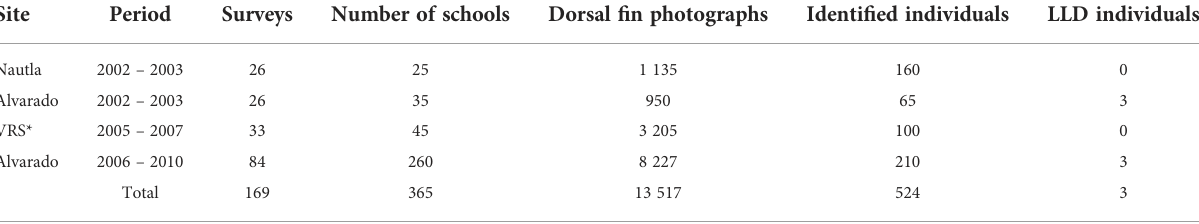
TABLE 1 Surveys and sightings of coastal bottlenose dolphins with and without gross LLD skin lesions at Veracruz, Gulf of